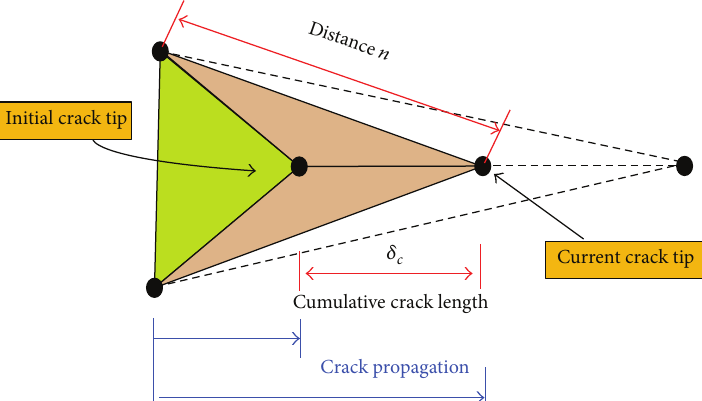
Figure 9: The definition of 𝛿 𝑐 and crack propagation.